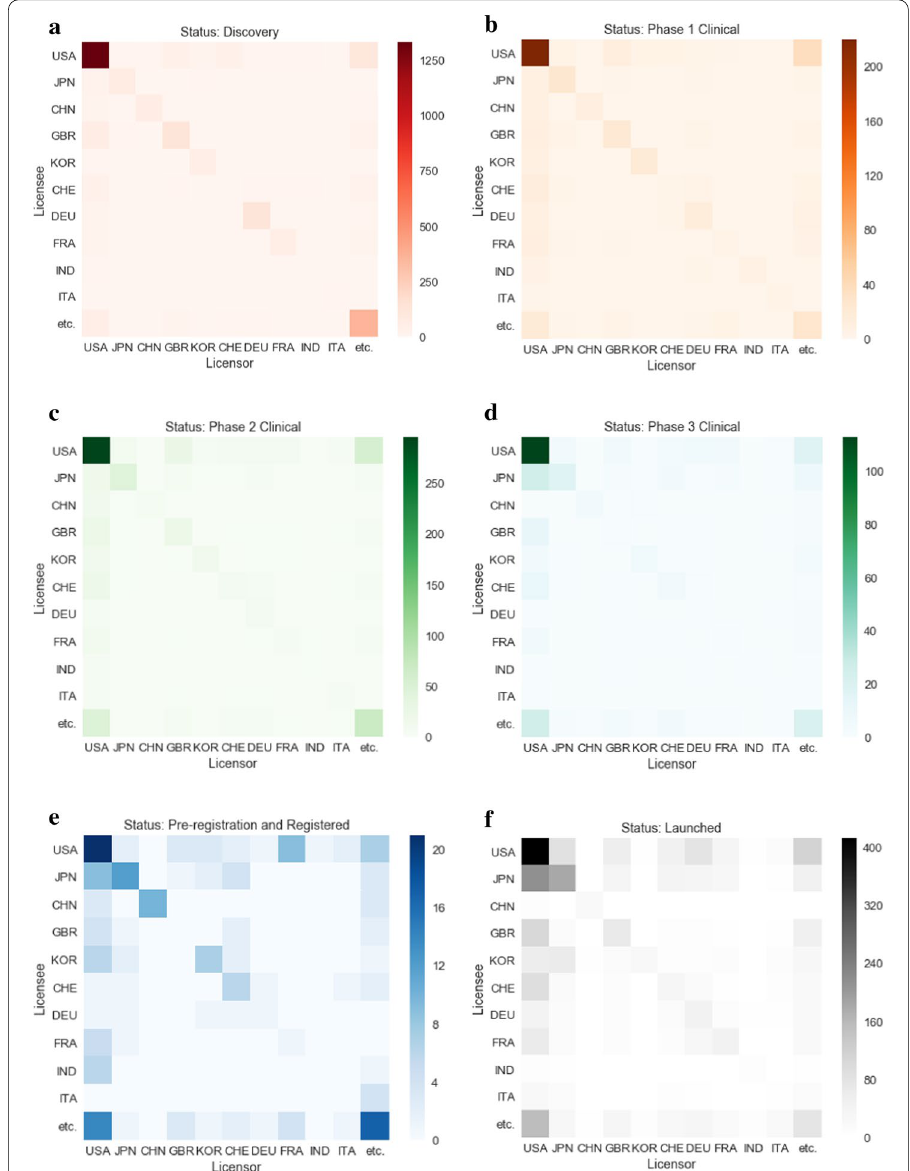
Fig. 3 Knowledge flows of drug pipelines between licenser and licensee at country level per pipeline status focused on the top 10 countries in Fig. 1. Each element represents the number of drug pipelines between countries, ignored the drug pipelines whose license has not shifted. The diagonal elements correspond to the number of shifts of licenses between companies in the